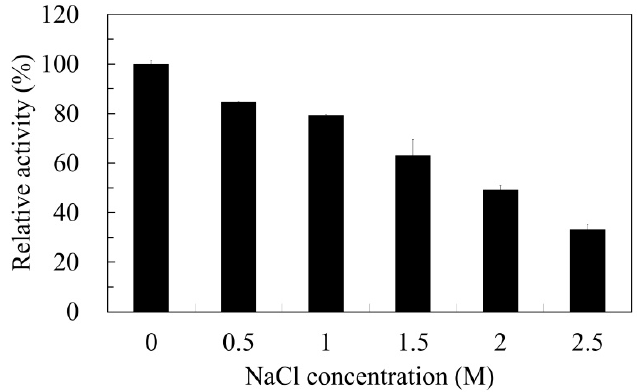
Figure 4. Effect of NaCl concentrations on Est6 activity. The residual activity was determined after incubation of the enzyme in the Tris-HCl buffer (pH 8.0) with different concentrations of NaCl at 30 °C for 30 min. The activity measurement was carried out using the standard enzyme assay. All samples and blanks were analyzed in triplicate. The relative activity of Est6 in the reaction buffer without NaCl was defined as 100%. Error bars indicate standard deviations.